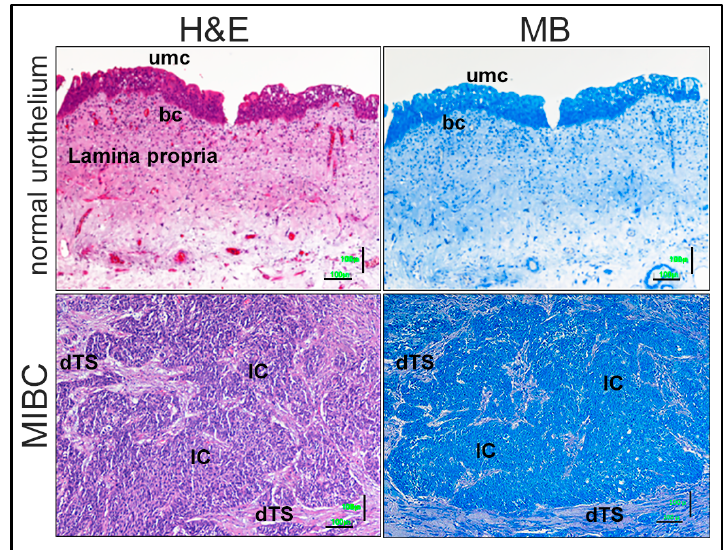
Figure 1. Example of consecutive FFPE tissue sections showing state of the art hematoxylin and eosin (H&E) and similar methylene blue (MB) staining of normal urothelium and muscle invasive bladder cancer (MIBC). Top microscopy photos represent normal urothelium H&E staining (left) and MB (right). Bottom photos represent MIBC H&E (left) and MB tissue stains (right). Different histological tissue components: surface epithelia cells: umc = umbrella cells; bc = basal cells; Lamina propria; dTS = desmoplastic tumor stroma; IC = invasive carcinoma. Lower right bar = 100 µm.